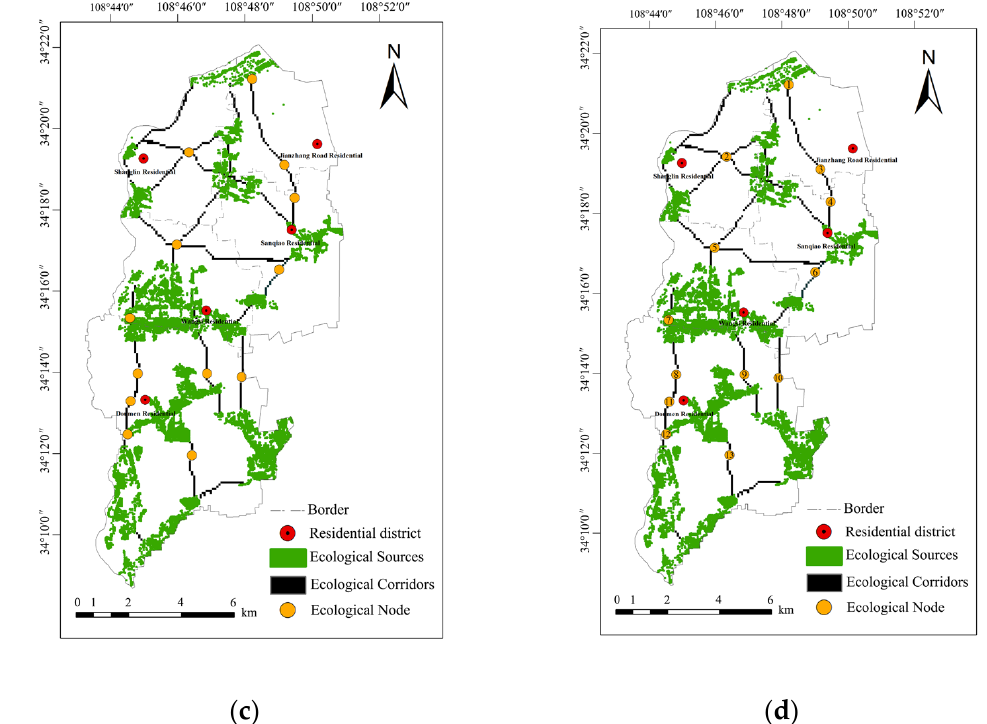
Figure 10. ( a ) Comprehensive resistance surface; ( b ) ecological corridors; ( c ) ecological nodes; ( d ) urban green spaces in Fengdong New City.